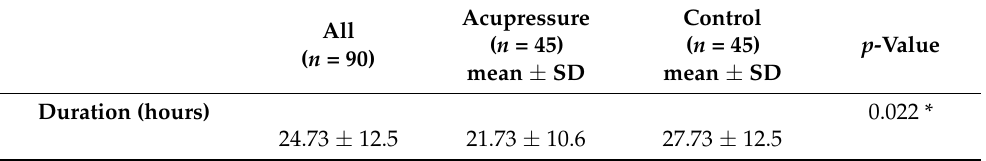
Table 4. Duration to achieve urine ketone clearance. * indicates statistically significant; p < 0.05.